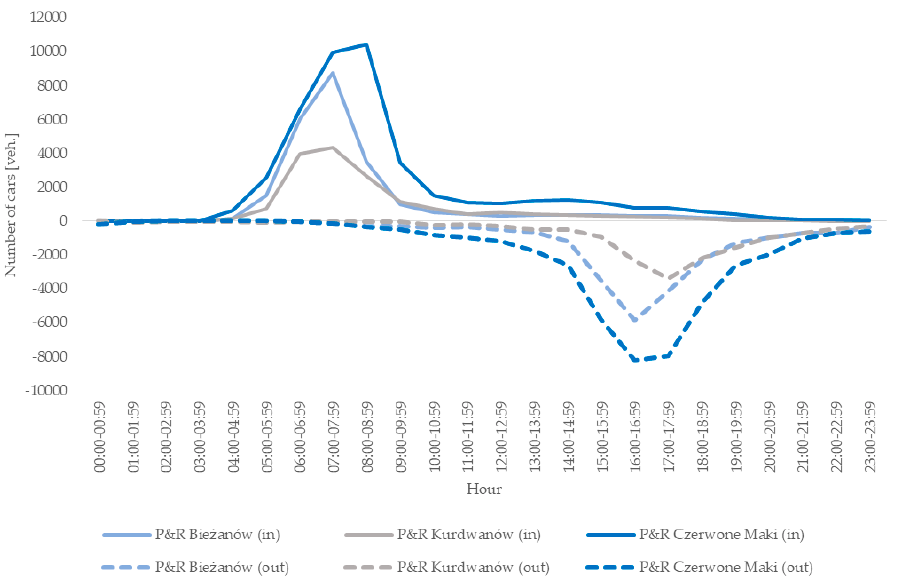
Figure 9. The number of vehicle entries (in) and exits (out) on working days at P&R parking in Cracow for all analyzed parking.